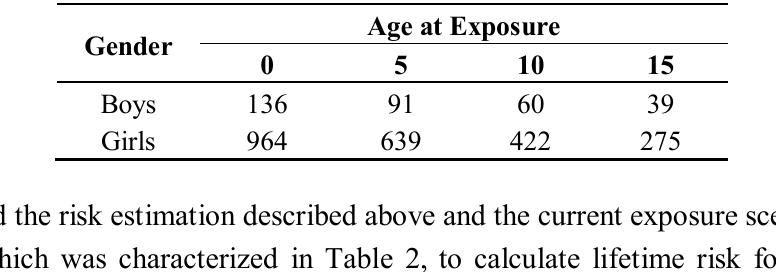
Table 5. Lifetime attributable risk of thyroid cancer incidence in the Chinese population.